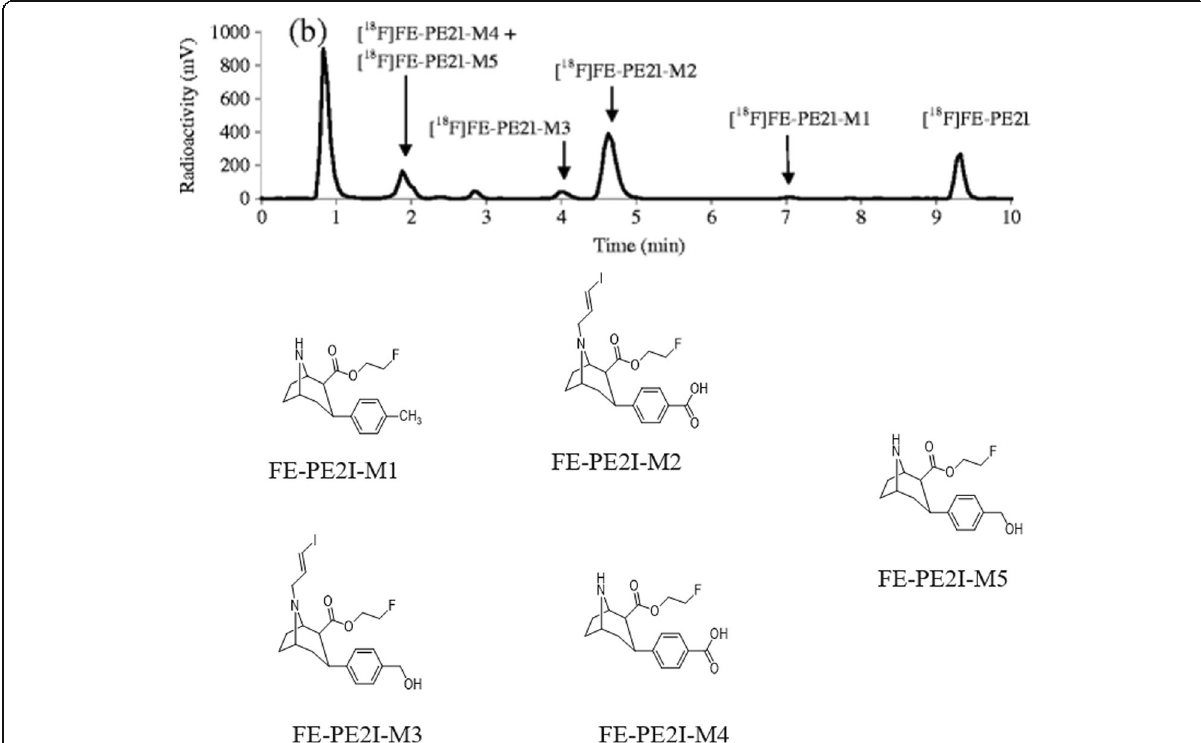
Fig. 6 Fast radio-LC chromatograms of rhesus monkey plasma collected 20min after administration of [ 18 F]FE-PE2I. Adapted with permission from Ref.